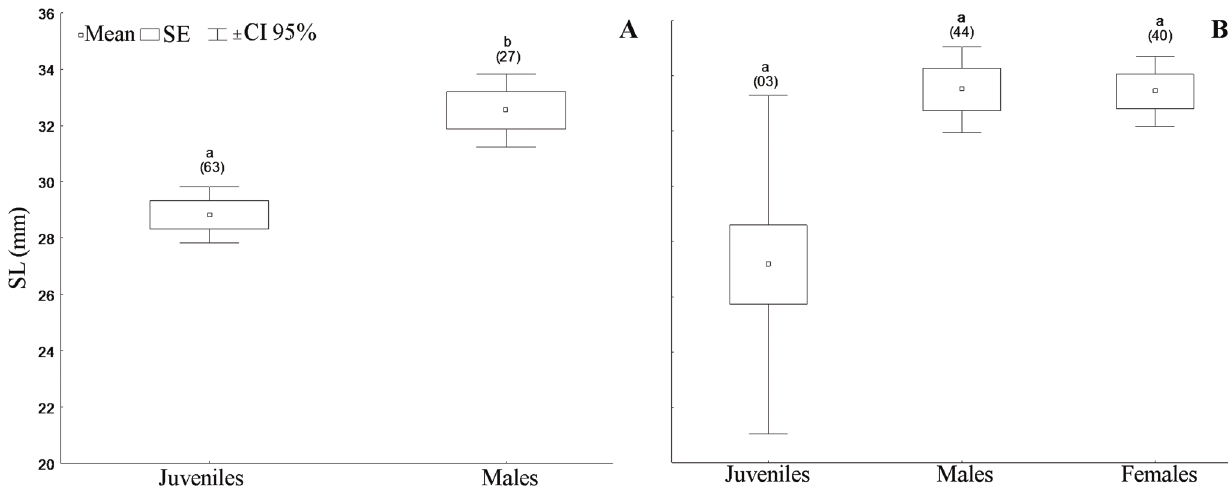
Fig. 3. Standard length (SL) of Austrolebias wolterstorffi sexually differentiated (males and females) and undifferentiated (juveniles), at 46 (A) and 53 (B) days after hatching. Different letters represent significant differences in SL means (A: t test, px < 0.05, B: ANOVA, Tukey, p > 0.05).